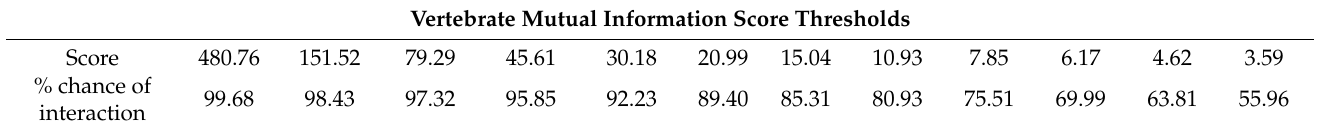
Table 1. The different probability thresholds for mutual information scores for vertebrates. Vertebrate Mutual Information Score Thresholds